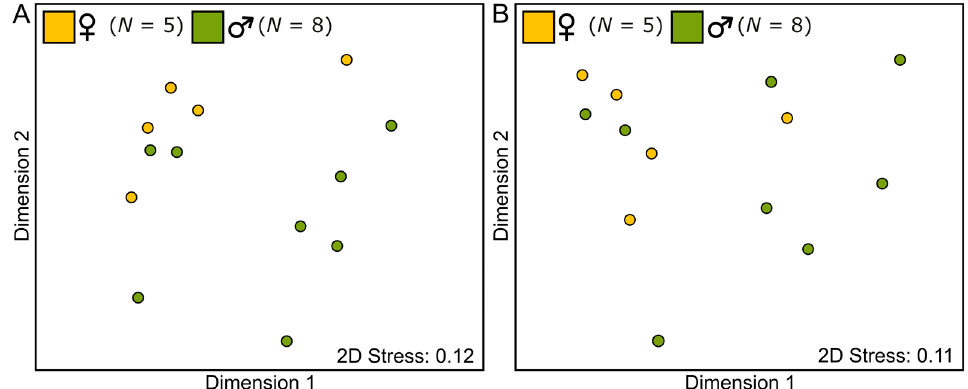
Figure 3. “Scent space” representation of male and female flowers of Catasetum maranhense visual- ised in two dimensions using non-metric multidimensional scaling (NMDS). ( A ) Semi-quantitative comparison based on Bray–Curtis similarity matrix (PERMANOVA: Pseudo-F 1,11 = 1.91, p = 0.09; fourth root transformation). ( B ) Qualitative comparison based on Sørensen resemblance matrix (PERMANOVA: Pseudo-F 1,11 = 1.88, p = 0.13; presence/absence transformation). Symbols represent the average scent pattern for each individual.